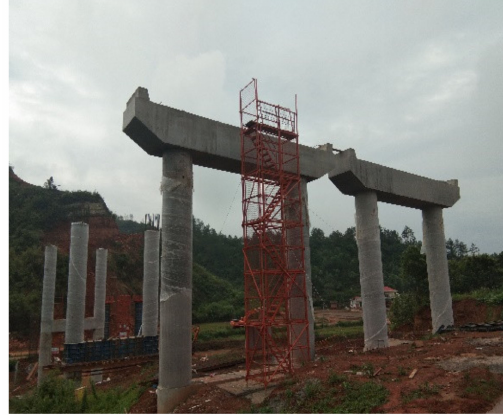
Figure 5. Field photograph of the test pier.